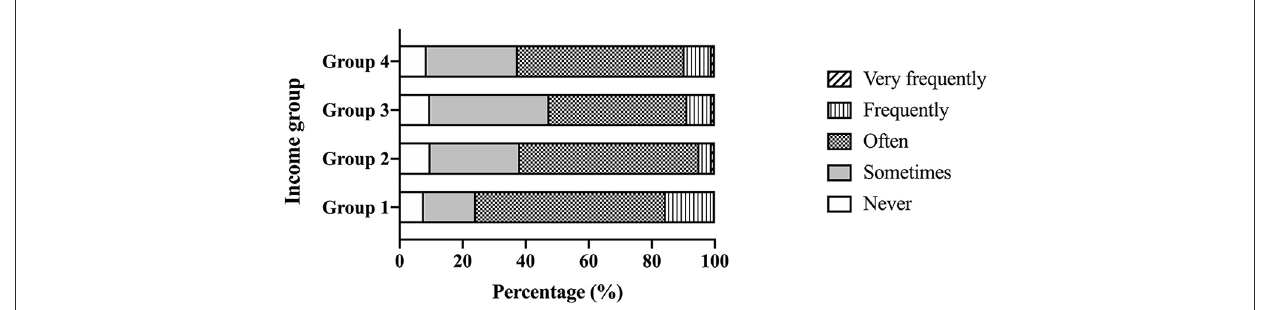
FIGURE3 Frequency of arguments due to gender ideologies by income group.